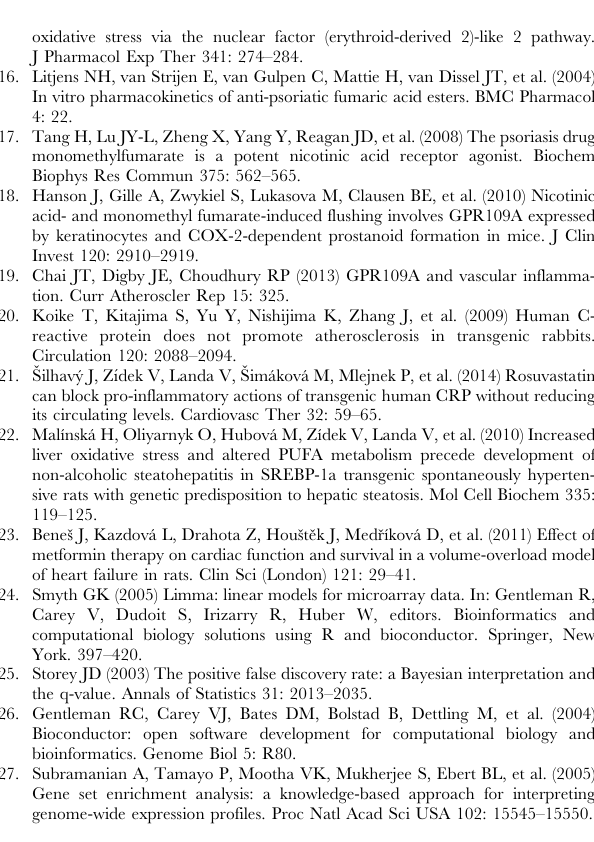
Table S1 Primers used for RT PCR